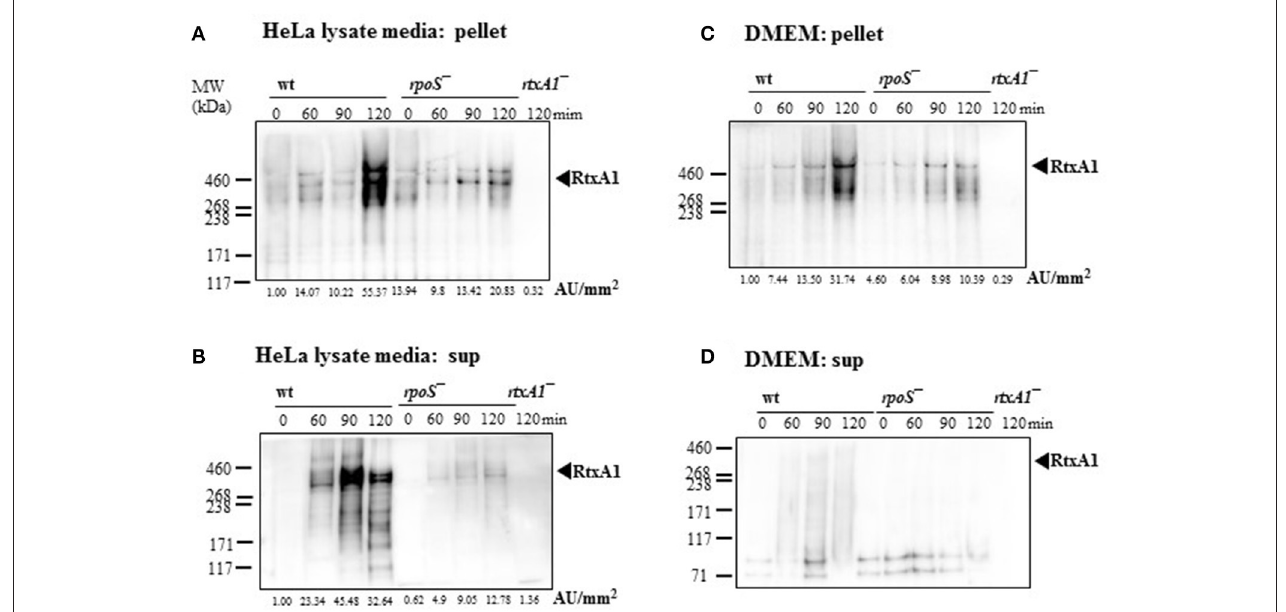
FIGURE 4 | Host factor-induced RtxA1 secretion was decreased by an rpoS mutation. (A) V. vulnificus wild-type, an rpoS mutant, or rtxA1 mutant strains at 2 × 10 8 CFU/mL were incubated with HeLa lysate media in a 5% CO 2 incubator at 37 ◦ C for the indicated times, and the pellets were collected for Western blot analysis. (B) RtxA1 Western blotting in the supernatant of bacteria-inoculated HeLa lysate media. (C) Bacterial cells at 2 × 10 8 CFU/mL were incubated with DMEM in a 5% CO 2 incubator at 37 ◦ C for the indicated times, and the pellets were collected for Western blot analysis. (D) RtxA1 Western blotting in the supernatant of bacteria-inoculated DMEM culture. RtxA1 toxin proteins were detected by Western blotting by using an anti-RtxA1 antibody specific to amino acids 1492–1970 (RtxA1-D2 domain). Protein levels were analyzed and quantified using Image J software. Abbreviation: AU, arbitrary